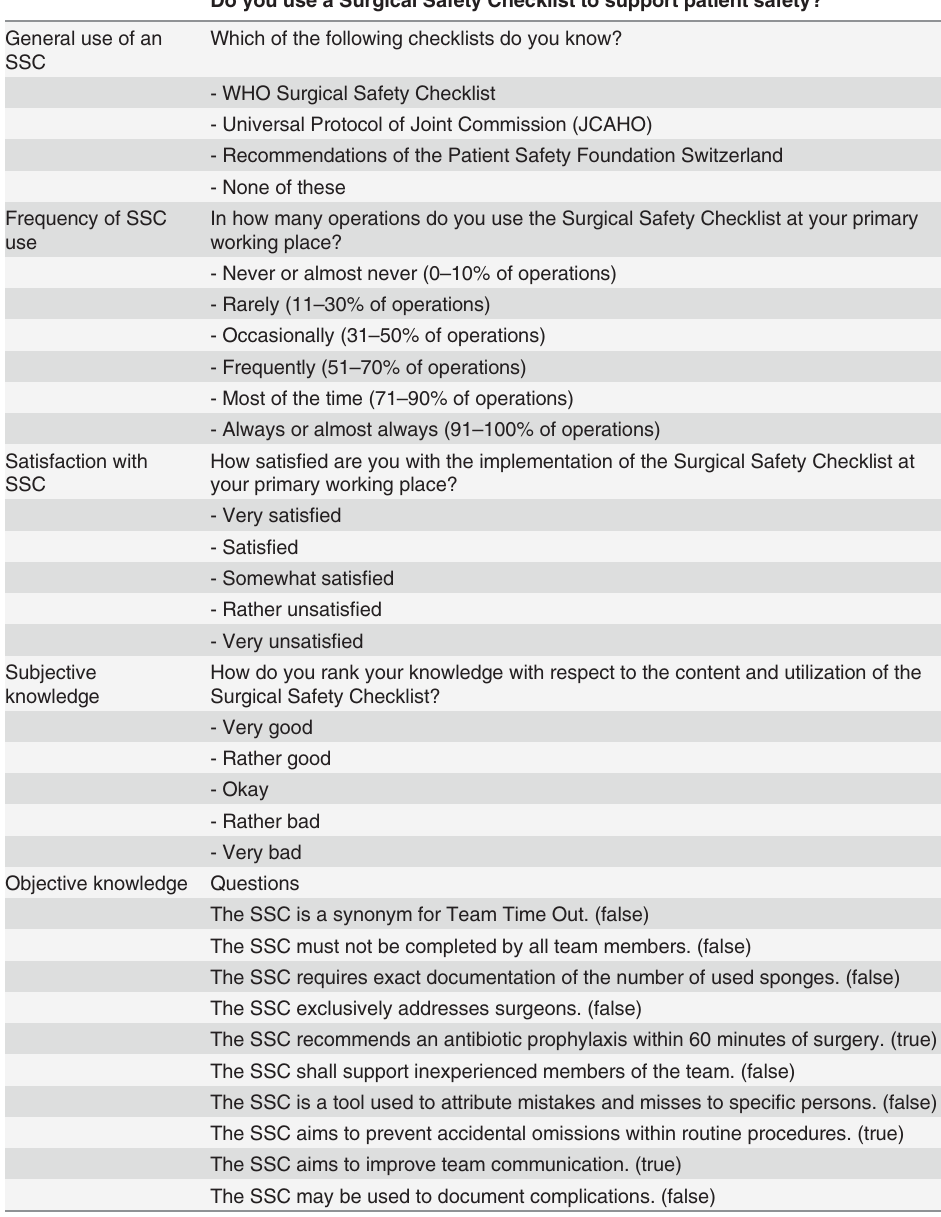
Table 1. Questionnaire items: general use of the SSC, frequency of SSC use, satisfaction with the implementation as well as subjective and objective knowledge (correct answer in brackets) as used in the Swiss survey